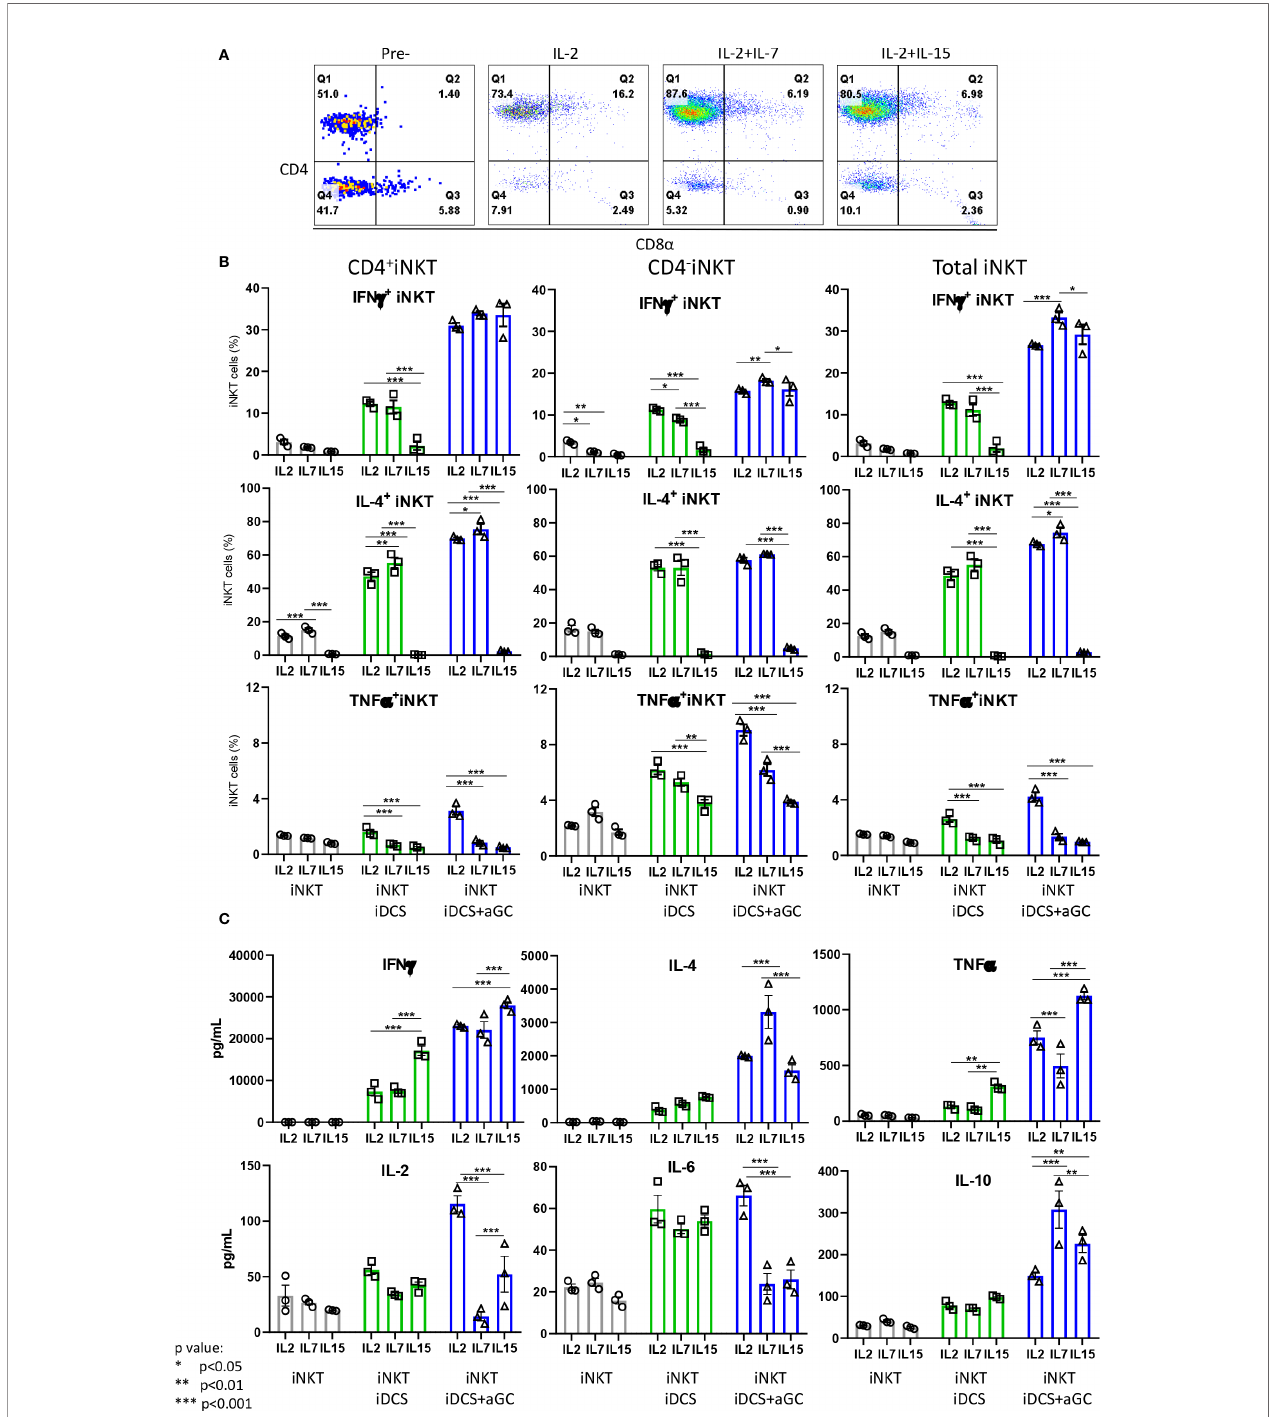
FIGURE 8 | IL-7 during antigenic stimulation enhances Th-2 cytokine expression by expanded human iNKT cells. (A) Representative fl ow cytometry dot plot of iNKT cells expanded in IL-2, IL-2+ IL-7, and IL-2+IL15. The iNKT cells were stimulated by irradiated dendritic cells in the presence or absence of a GalCer for 48 h. For intracellular cytokine production, iNKT cells were incubated with protein transport inhibitor for another 6 h prior to intracellular cytokine staining. The percentages of cytokine + iNKT cells from the total iNKT cells or CD4 +/- iNKT cells were shown (B) . The cytokines present in culture supernatant was assessed by a human Th1/ Th2/Th17 Cytometric Bead Array kit (C) . Experiment was performed with 3 independent donors in triplicates per condition, and representative experiment was presented. Student < test was used to compare the differences of cytokine production between conditions, and represent by *p < 0.05, **p < 0.01 and ***p < 0.001, respectively, not signi fi cant are not